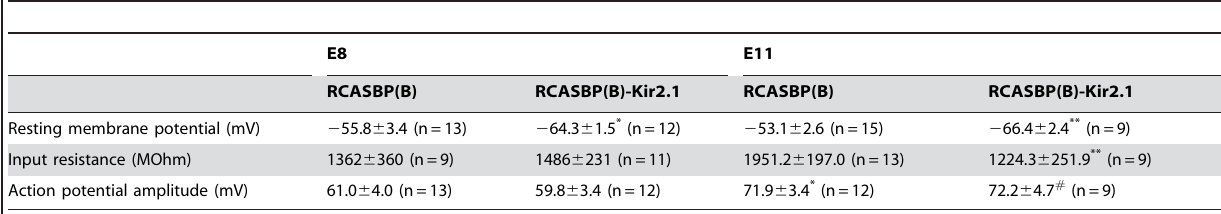
Table 1. Changes in resting membrane potential, input resistance and action potential amplitude in E8 and E11